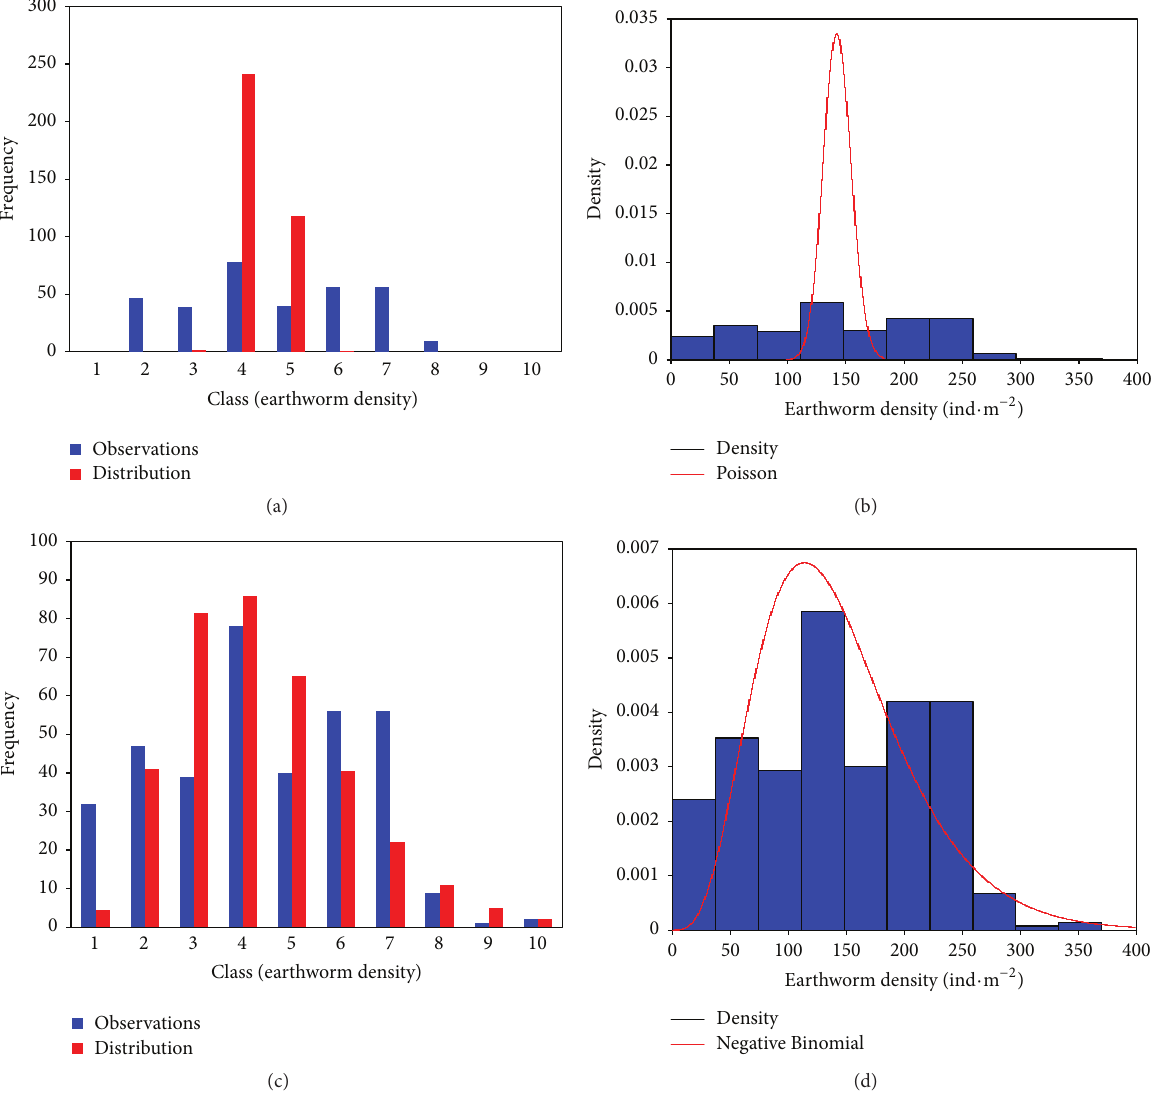
Figure 2: Showing the observed and expected frequency distribution and probability density function for (a, b) observed earthworm density, Poisson(random)distributionand(c,d)observedearthwormdensity, andNegativeBinomial(clumped)distributioninpineappleplantations of Tripura.